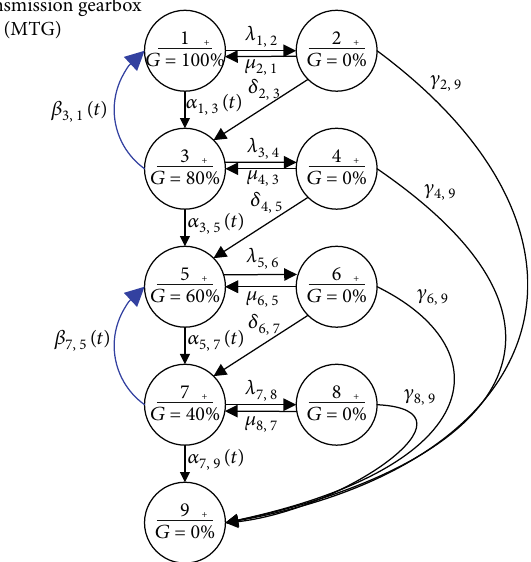
Figure 13: State-transition diagram of the main transmission gearbox.